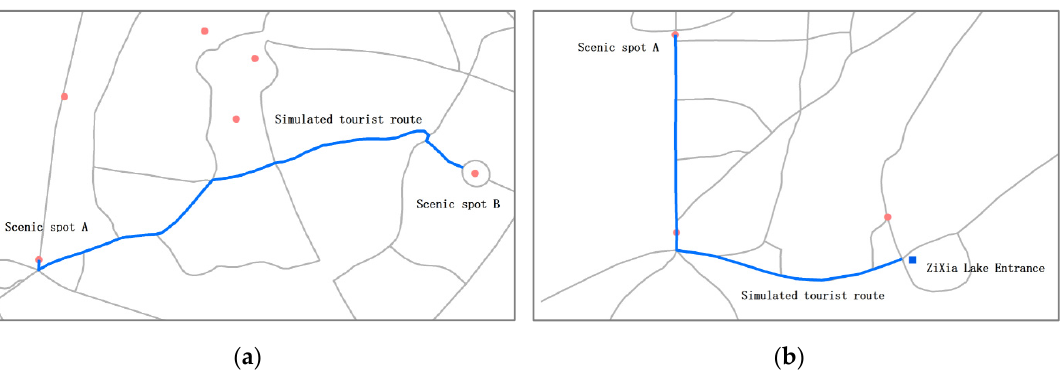
Figure 3. The simulated tourist routes: ( a ) The weighted shortest paths between each scenic spot, ( b ) The weighted shortest paths between scenic spots and entrances.